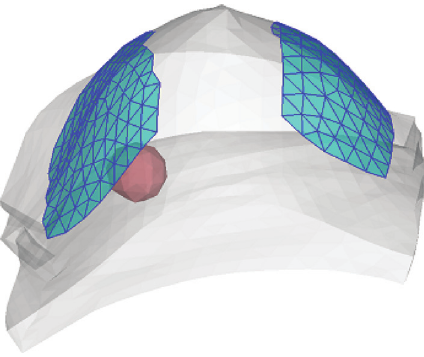
Figure 5: Titled compression is given by two paddles. The one close to tumor gives displacement loading on breast phantom and another is fixed during